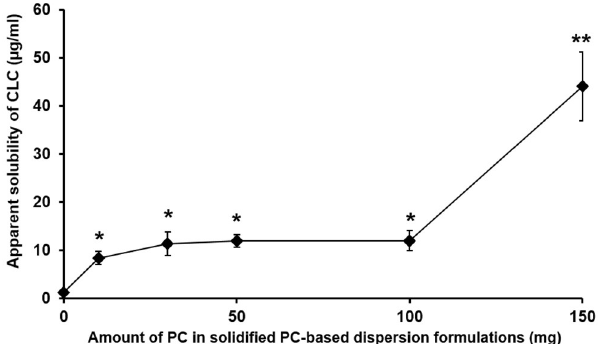
Figure 2. Apparent aqueous solubility of CLC incorporated in PC-based dispersion formulations powderized with Neusilin ® US2. The PC-based solid dispersion (SD) formulations tested were prepared with different amounts of PC, 100 mg CLC, and 200 mg Neusilin ® US2. The values are mean ± SD ( n = 3). Single and double asterisks denote the statistical differences at P < 0.01 and P < 0.001, respectively, in comparison to the solubility of CLC alone.